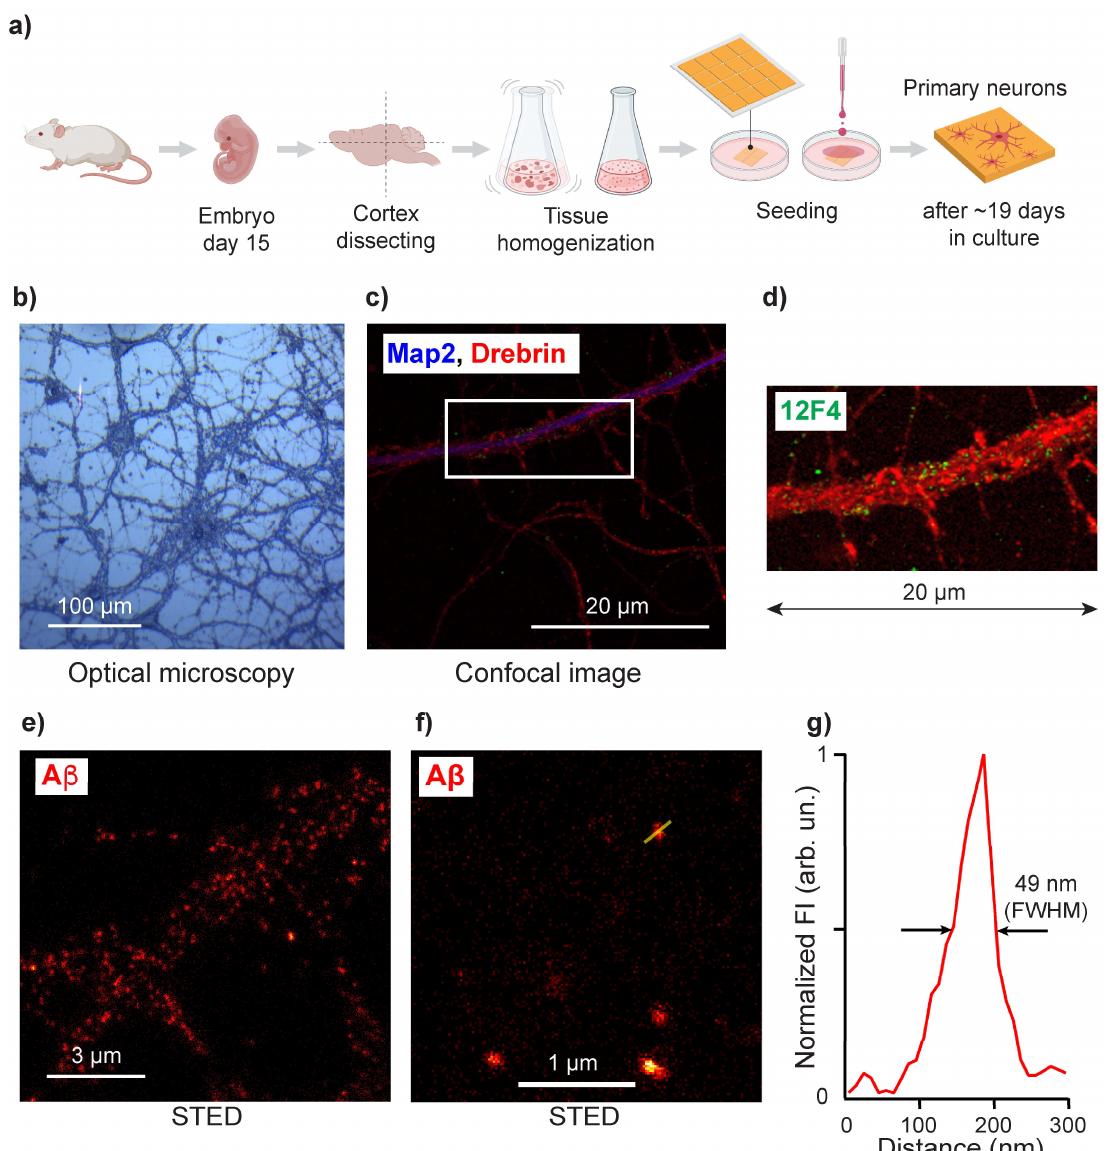
Figure 1. Sample preparation and characterization of intraneuronal A β aggregates. ( a ) Isolation of primary neurons. Cortex homogenate extracted from day 15 embryos was seeded on 100 nm gold-coated Si. After 19 days of growth and maturation in culture, neurons were fixed and air-dried. ( b ) Optical image of cultured APP/PS1 transgenic neurons on AFM substrate cultured for 19 days. A scanning electron micrograph of cultured neurons is shown in Figure S2. ( c ) Confocal micrograph of APP/PS1 transgenic neurons, where the blue channel corresponds to the neuronal marker Map2, and the red channel shows the post-synaptic marker Drebrin; A β 42 labeled with 12F4 antibody is green. ( d ) Confocal micrograph of APP/PS1 transgenic neurons, where the green channel is used to map A β along the neurite labeled with Drebrin. ( e , f ) STED images of APP-KO neurons treated with A β (1-42), indicated by the red channel. ( g ) STED signal intensity profile of a single A β aggregate (shown in the middle panel) with a size of ca. 50 nm. A β size distribution is neurons is shown in Figure